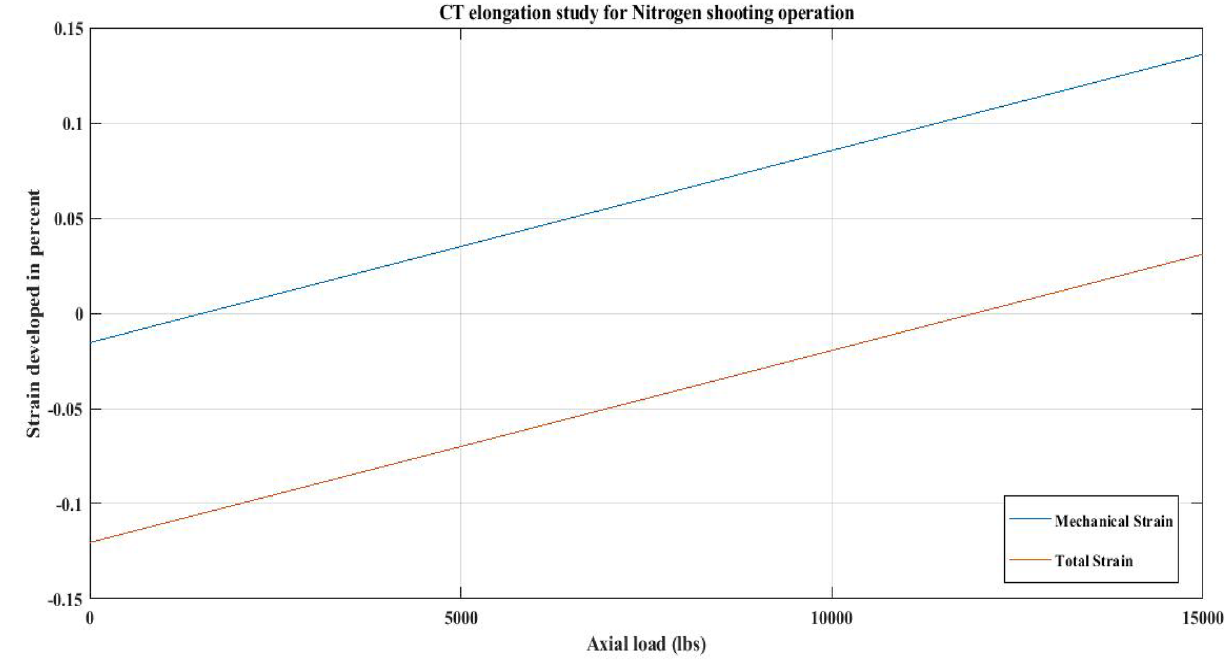
Figure 30. Axial load vs strain in CT (%).